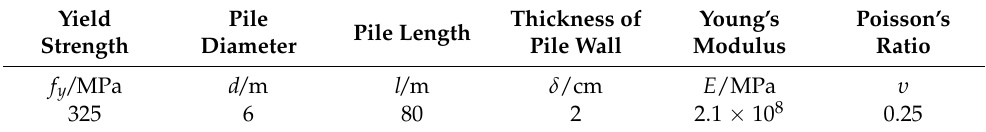
Table 1. Physical parameters of the